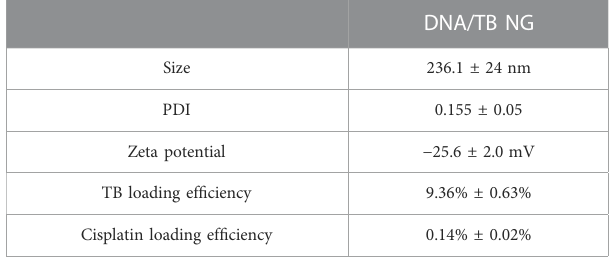
TABLE 1 DLS analysis and TB loading ef fi ciency of DNA/TB NG.